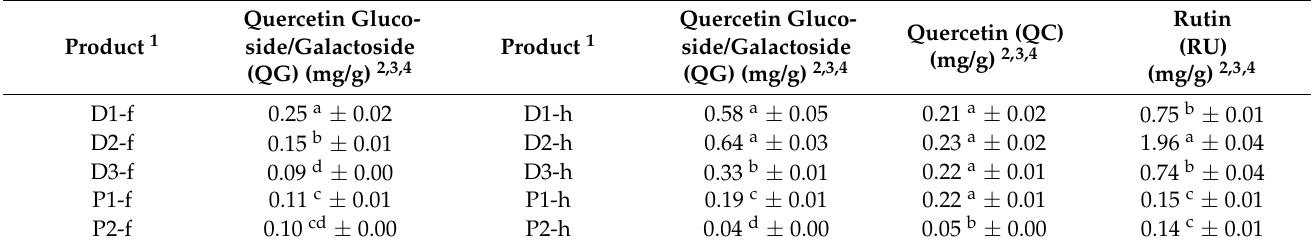
Table 5. Flavonoid content for fruit and husk extracts of Physalis peruviana